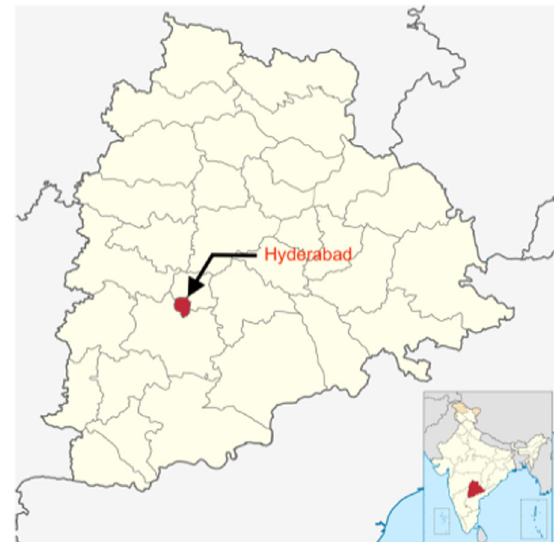
Fig. 1 Study area (Hyderabad,